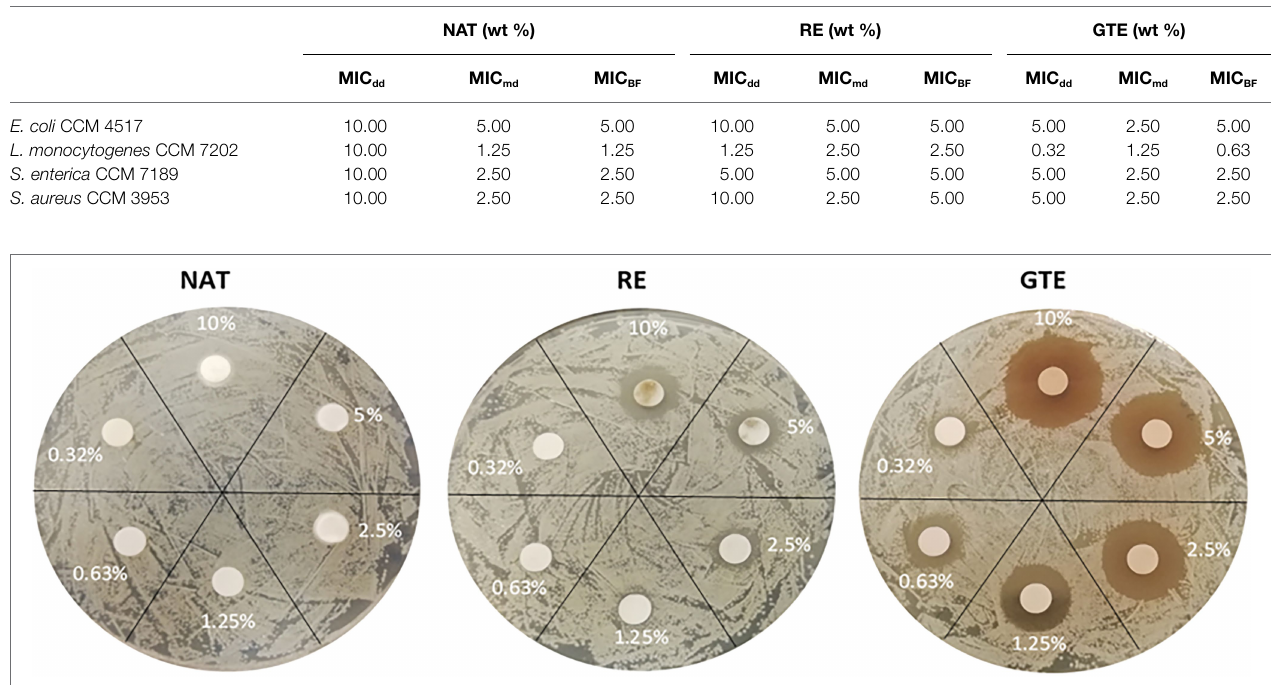
FIGURE 2 | Influence of natural substances (NAT, RE, and GTE) in various concentrations (wt %) to viability of Listeria monocytogenes CCM 7202 (disk diffusion method